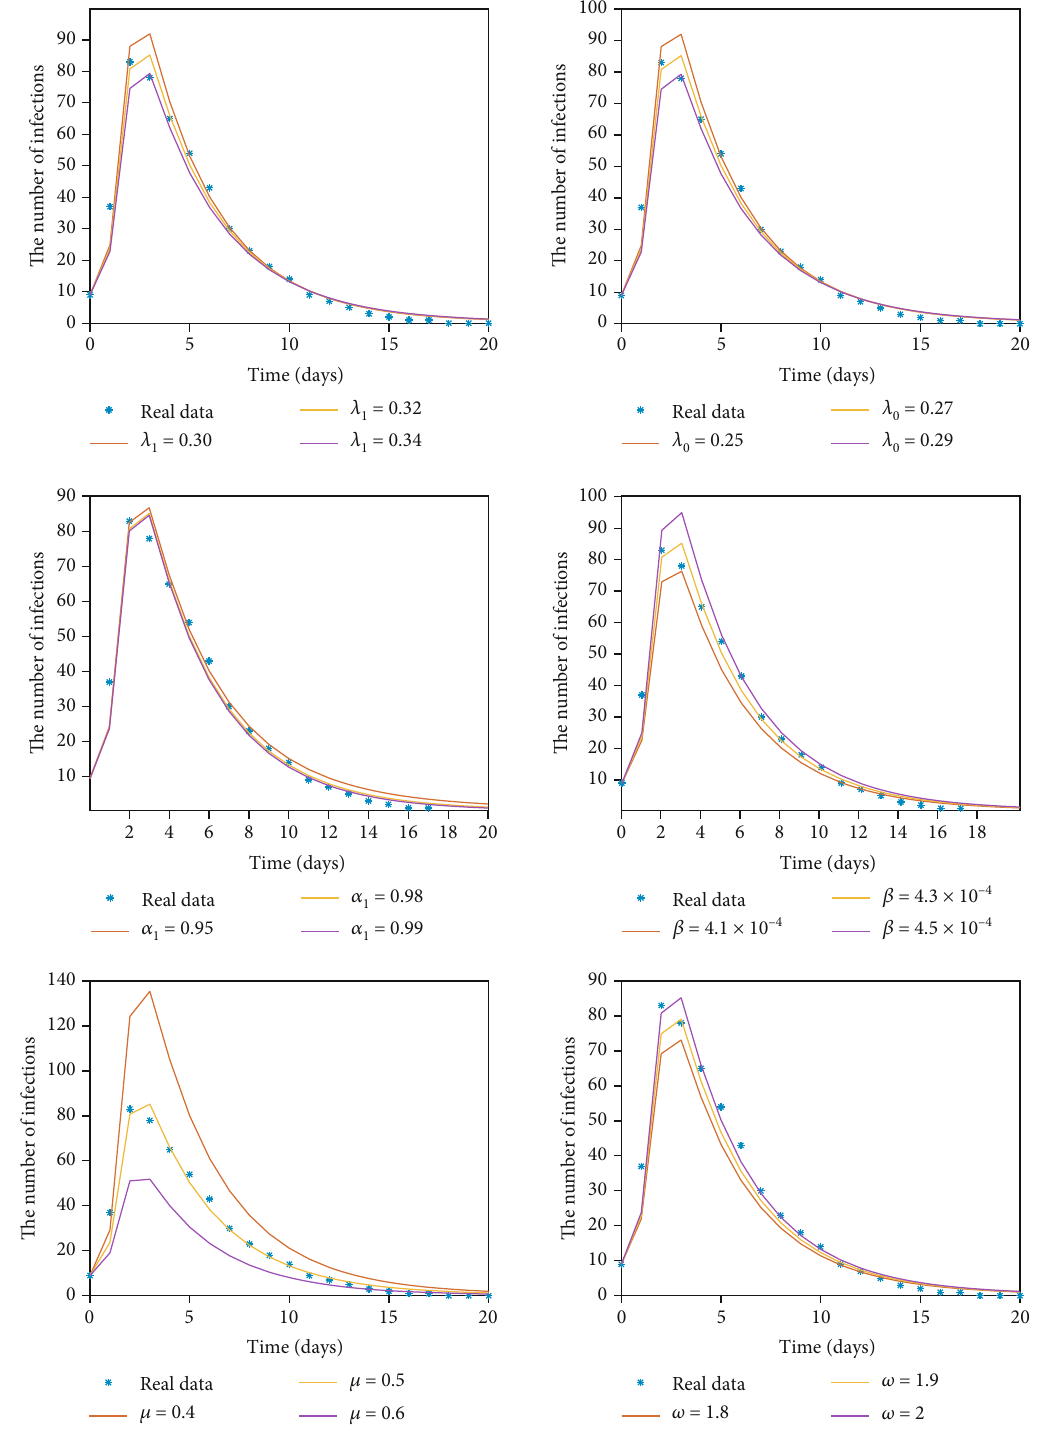
, λ , α , β , μ , ω on the quantity of infections I ð t Þ when the remaining parameters remain 1 0 1